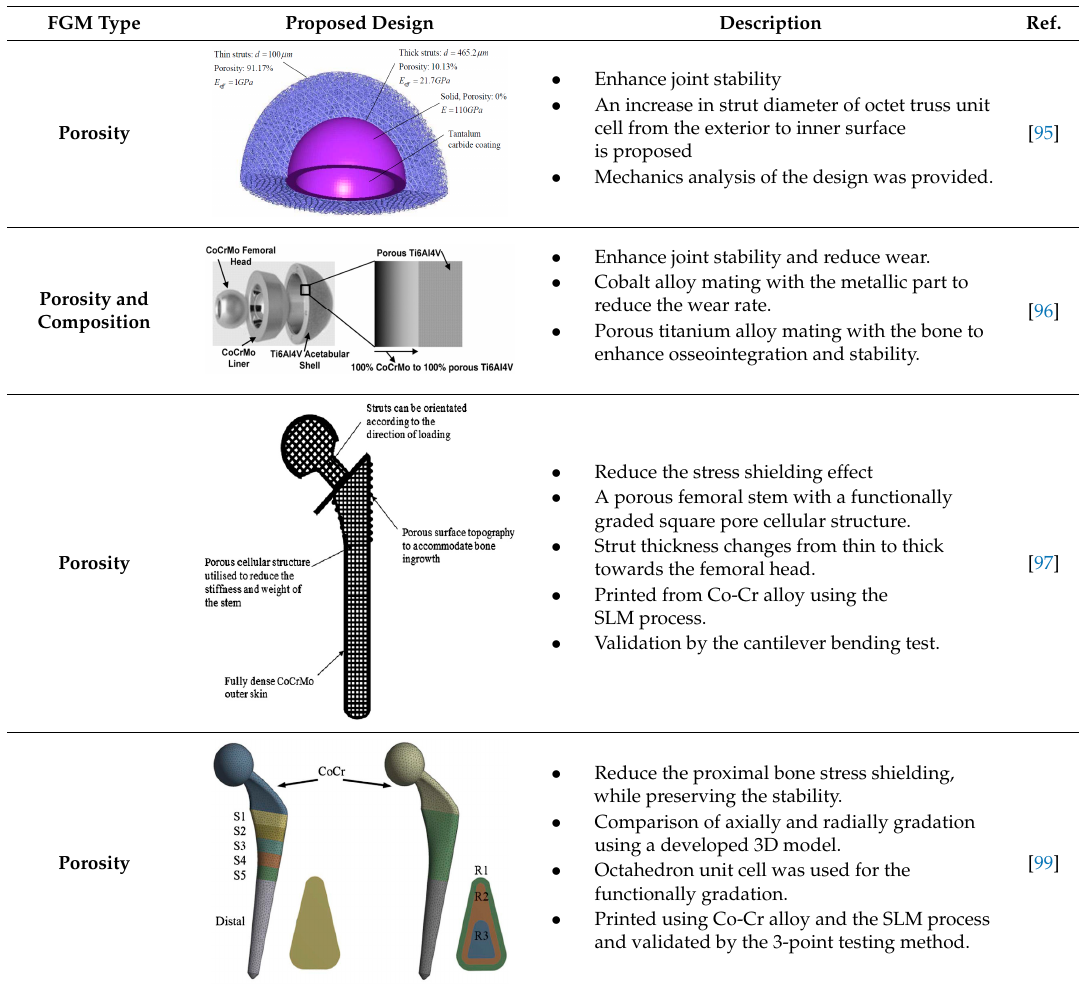
Table 3. Case studies for using FGM for biomedical implants.